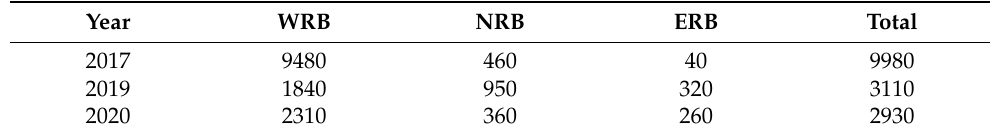
Table 5. Inundation areas of cropland in PRB (unit: